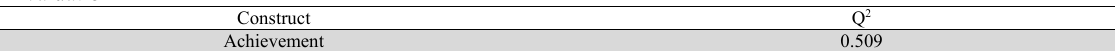
Q 2 Evaluation Construct Q 2 Achievement